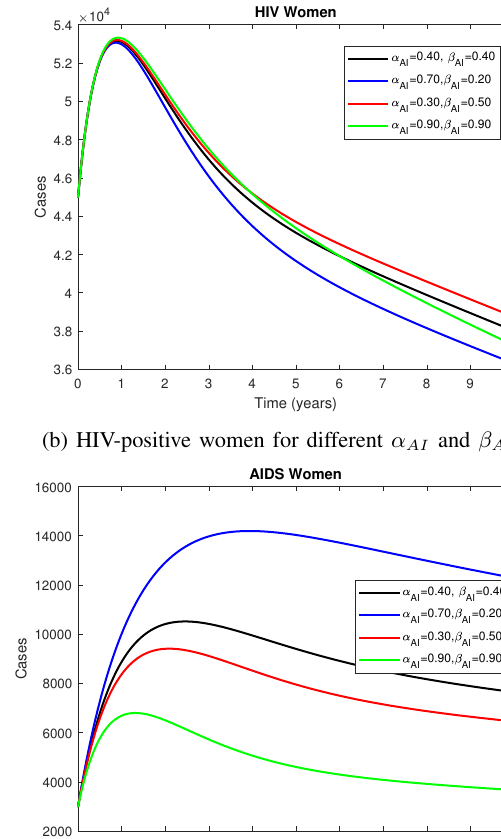
(a) HIV-positive men for different α AI and β AI . (b) HIV-positive women for different α AI and β AI .